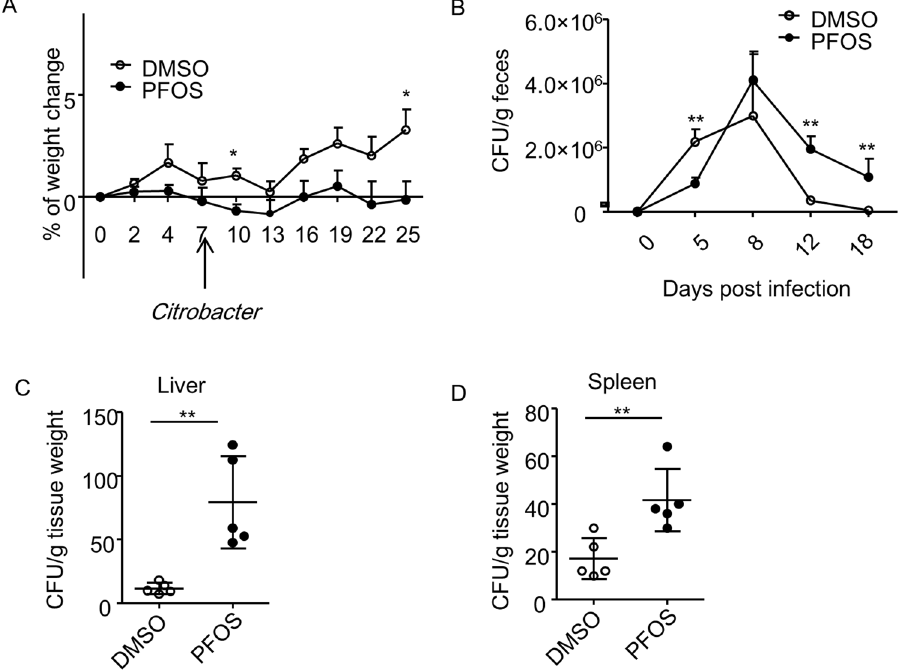
Figure 1. PFOS exhibits differential effects during different stages of mouse C. rodentium infection. ( A ) Wild- type mice were treated daily by oral gavage with DMSO or PFOS (2 mg/kg) in water for 7 days. Mice were then infected with 10 10 Colony-forming unit (CFU) of C. rodentium . PFOS treatment continued on a daily basis through the whole time course of observation. Percentages of weight change of the two groups of mice before and after C. rodentium infection at indicated time points were shown. Data were pooled from 4 mice from each group. Error bars represent SEM. Data are representative of at least 3 independent experiments. ( B ) CFU counts of C. rodentium in the fecal pellets at indicated time points after infection were shown. Data were pooled from at least 4–8 mice from each group for all time points from two experiments. Error bars represent SEM. ( C ) CFU counts of C. rodentium from spleen and liver homogenates cultures at 21 days after infection were shown. Horizontal lines show the mean. Error bars represent SEM. The data are representative of three independent